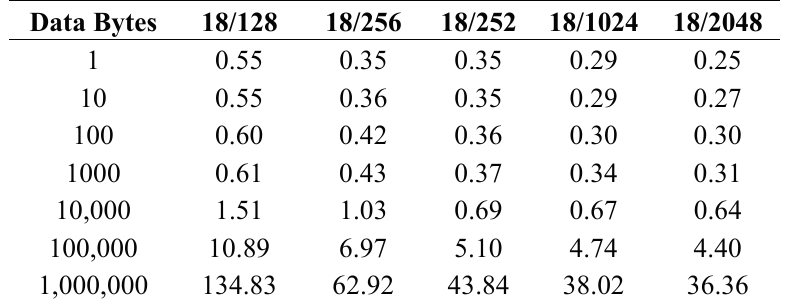
Table 1. Time (s) to transmit a data packet using OBEX (scan